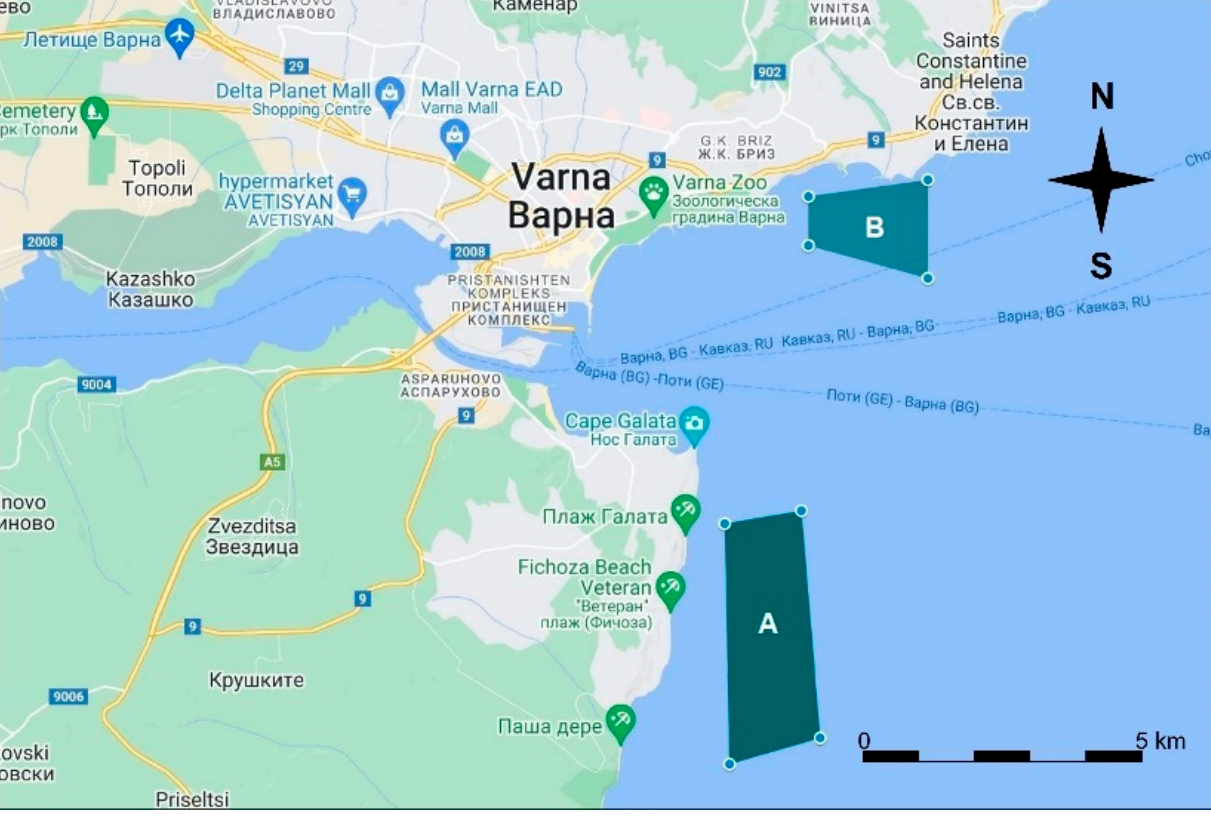
Figure 1. Varna seaports (A-Summer and B-Winter seaports), developed by authors based on Google My Maps, https://www.google.com/intl/en-GB_ALL/permissions/geoguidelines/, accessed on 20 October